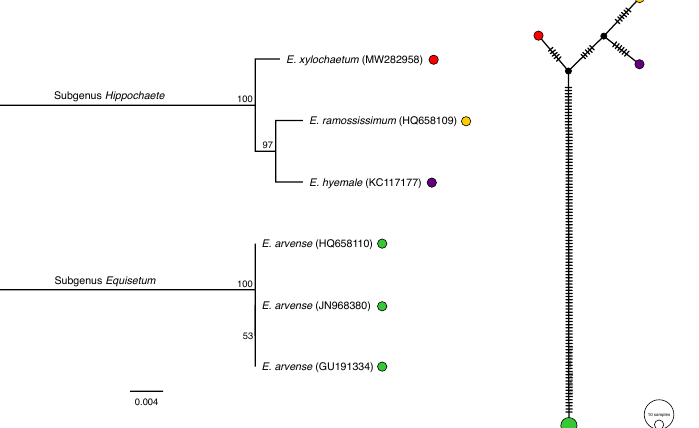
Figure 5. Phylogenetic estimation and TCS network of Equisetum rpoB sequences. The scale bar of the tree represents the estimated number of nucleotide substitutions per site. The maximum- likelihood bootstrap values are reported at the respective nodes. The colours of taxa present in the tree correspond with the colours in the TCS haplotype map. The size of the circle represents the number of the taxa that share the same